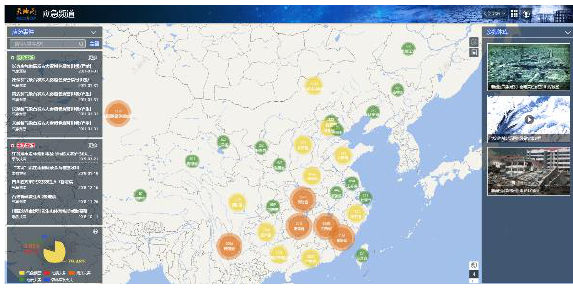
Figure 3. National Geographic Information Public Service Platform for Disaster